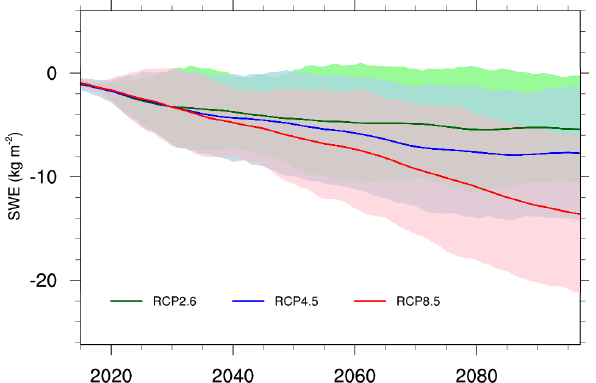
Figure 8. Projected changes in mean annual SWE over Northern Hemisphere land during the 21st century for all three RCPs (green: RCP2.6; blue: RCP4.5; red: RCP8.5). The mean value for the 1986– 2005 reference period is subtracted from all values. Also shown is the multi-model mean for all available models for each scenario. The 10-year running average was derived for each model before calculating the multi-model mean. Shaded areas denote the inter- model standard deviation for each ensemble